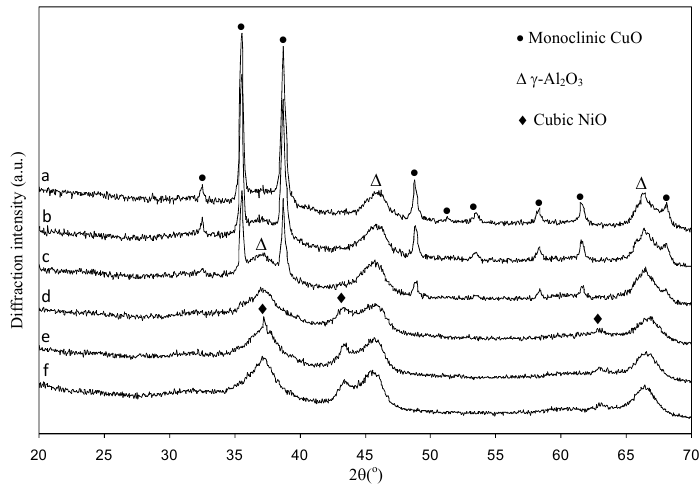
Figure 2. XRD patterns of 18 wt. % Ni 1 − x ‐ Cu x /Al 2 O 3 ( x = ( a ) 1, ( b ) 0.7, ( c ) 0.5, ( d ) 0.3, ( e ) 0.9, ( f ) 0).